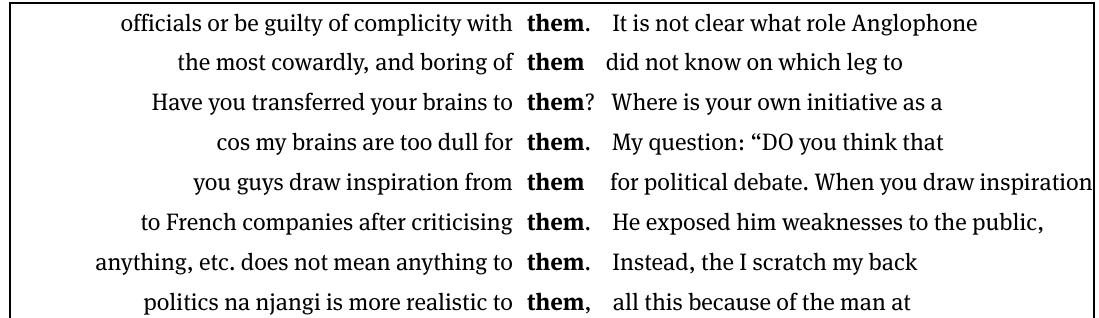
Figure 9. Sample concordance list for